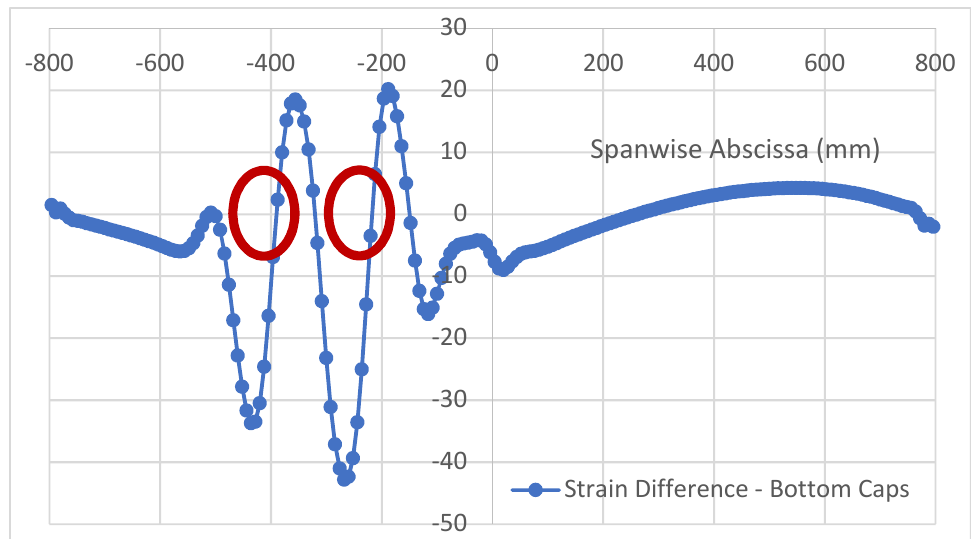
Figure 24. A comparison of the longitudinal strain functions in the bottom and top caps of the two C-spars; evidenced in the red circle, a slight modulation of the signal revealed in the bottom cap of the damaged spar.